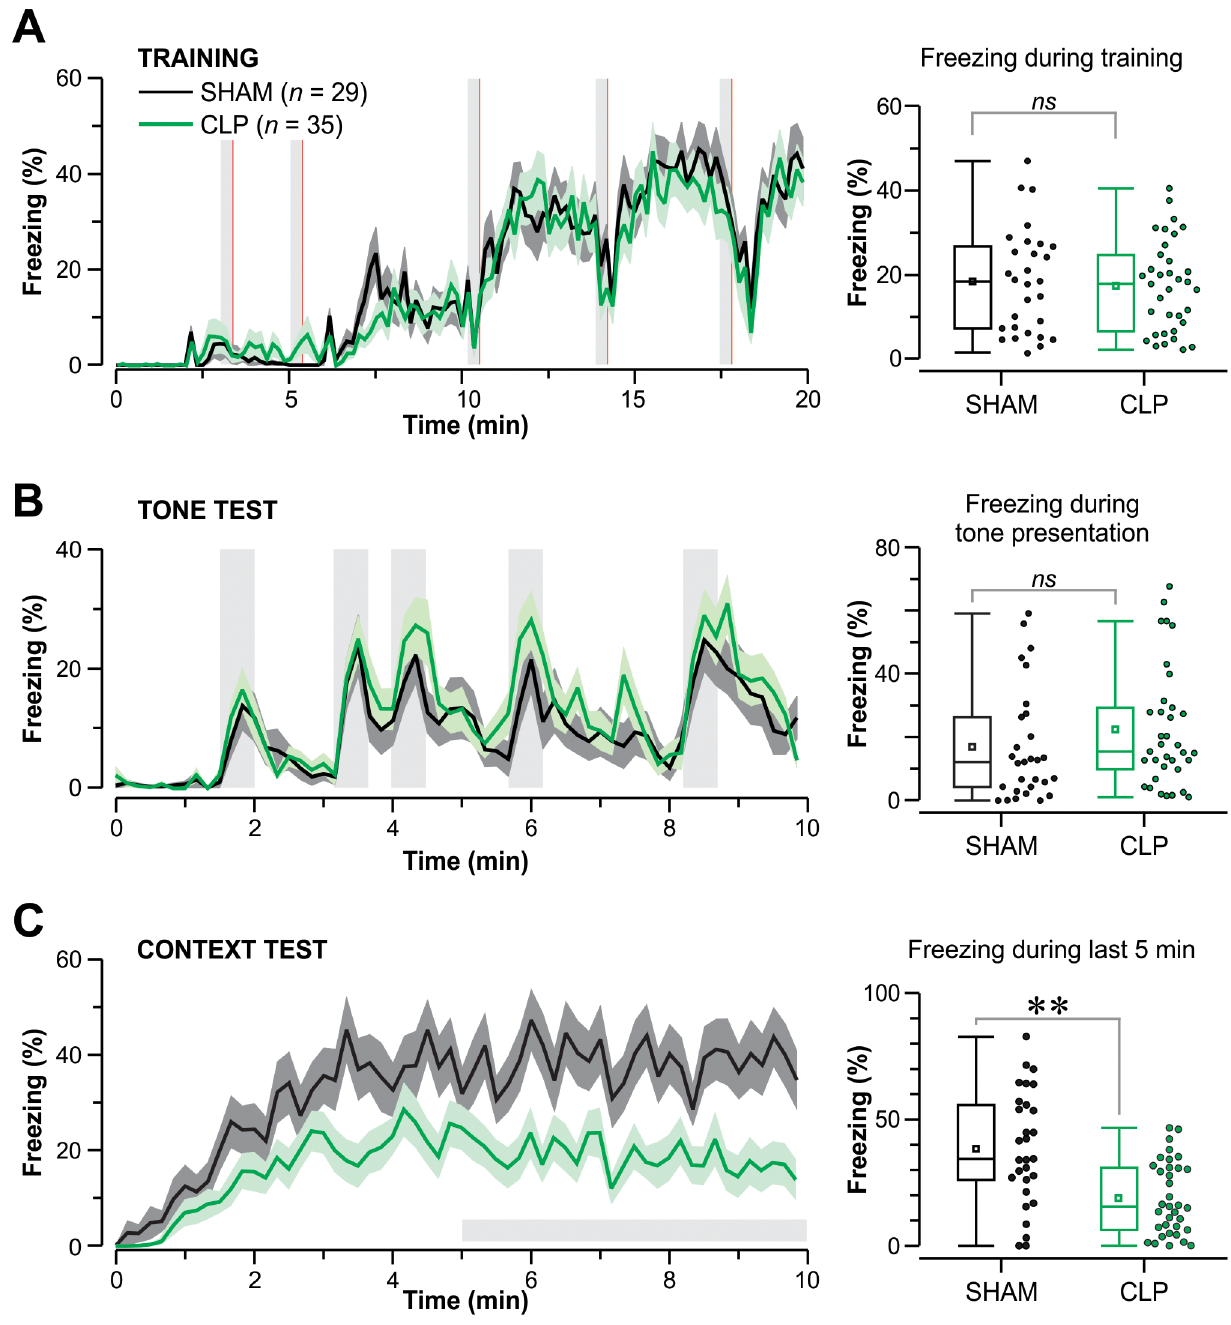
Figure 3. Impaired contextual fear memory in CLP-exposed mice. (A) (Left) The graph shows the progression of freezing (mean ± SEM) during the training phase. Delivery of the tone CS (vertical light gray bars) coterminates with the foot-shock US (red lines). (Right) The box plot shows the freezing levels during the last 30 s of training, which are not significantly different ( ns ) between groups. (B) (Left) The graph shows freezing (mean ± SEM) during the tone memory test, in which the light gray bars indicate delivery of the tone CS. (Right) The box plot with the freezing levels during the tone presentations, which are similar between groups. (C) (Left) The graph shows freezing (mean ± SEM) during the context memory test. The gray bar indicates the 5–10 min interval during which the freezing response is calculated. (Right) The box plot shows significantly different freezing during the last 5 min (** P < 0.01 by t